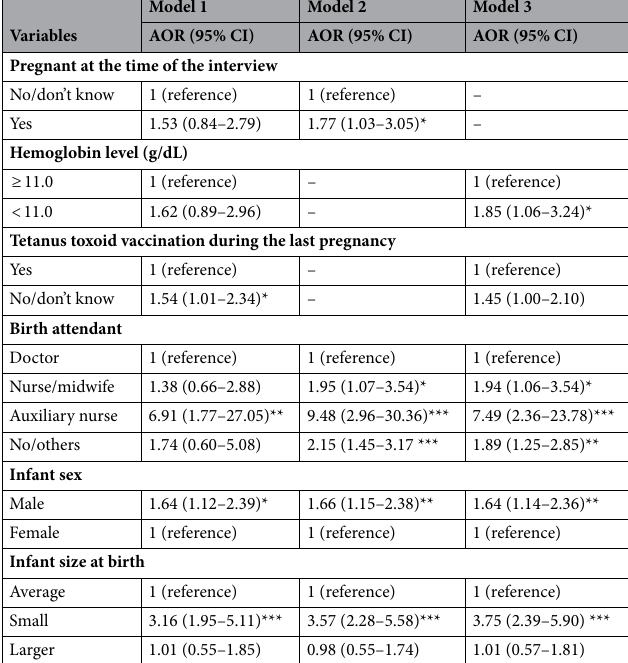
Table 4. Results of multivariate logistic regression models among all women. AOR adjusted odds ratio, CI confidence interval. Model 1: forced-entry, Model 2: forward-selection, Model 3: backward-selection. *P < 0.05. **P < 0.01. ***P <